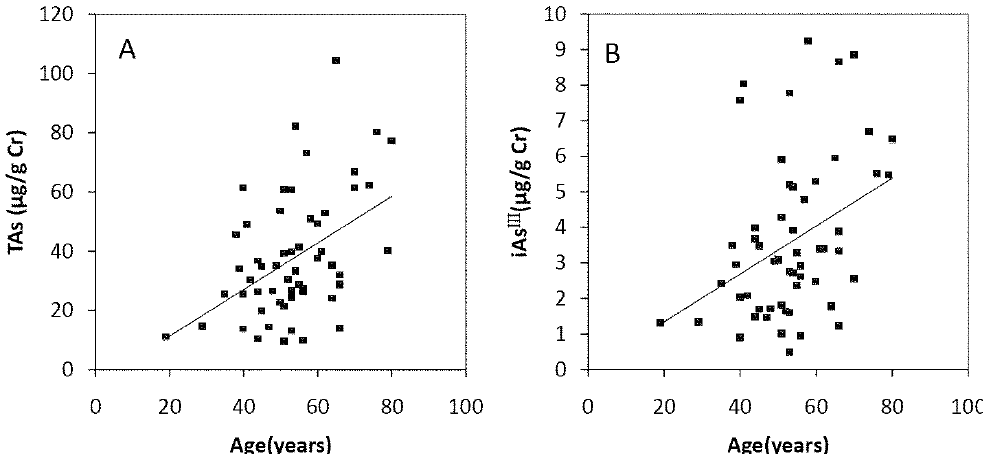
Figure 3. Correlation of age with ( A ) TAs ( R = 0.411, p = 0.001); ( B ) iAs III ( R = 0.343, p = 0.009); ( C ) iAs V ( R = 0.422, p = 0.001); ( D ) MMA V ( R = 0.439, p = 0.001); ( E ) DMA V ( R = 0.353, p = 0.007) in the